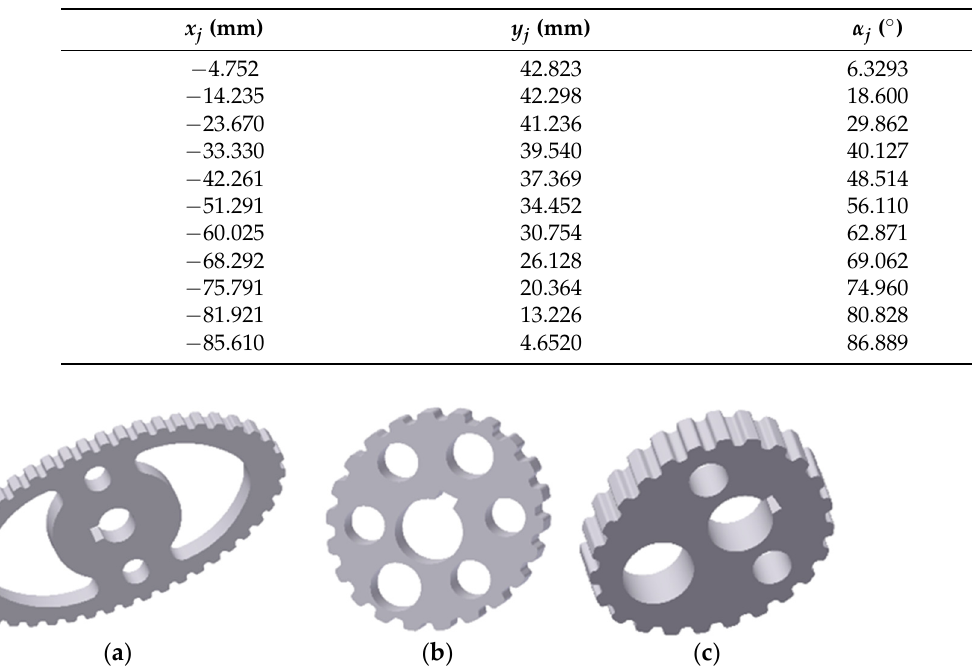
Table 1. Summary of data for building a CAD model of an ellipse wheel.